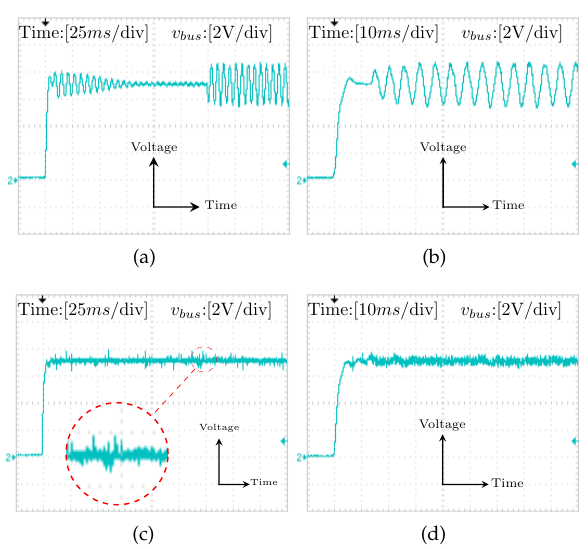
Figure 15. Experimental results: ( a ) The instability using the conventional controller by sequential loading; ( b ) The instability at full load with the conventional controller; ( c ) The improved performance using the proposed controller with sequential loading; and ( d ) The response of the system at full loading using the proposed